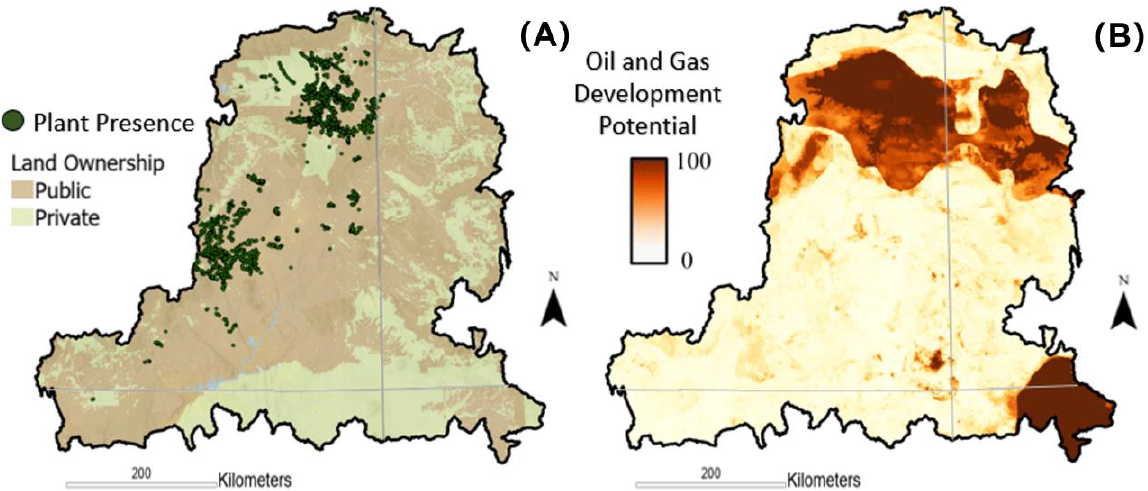
Figure 2. Spatial depictions of data in the Colorado Plateau. ( A ) Geographic locations of flowering plant occurrences distributed across private and public land tenures; ( B ) Oil and gas development potential probability model.